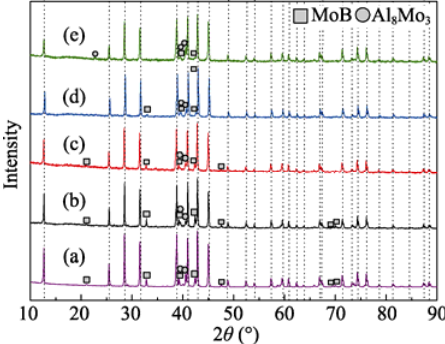
XRD patterns of samples synthesized from 1Mo/ n Al/1B by SHS: (a) n = 1.0, (b) n = 1.1, (c) n = 1.2, (d) n = 1.3, and (e) n = 1.4 where the dotted lines represent MoAlB (PDF Card No.